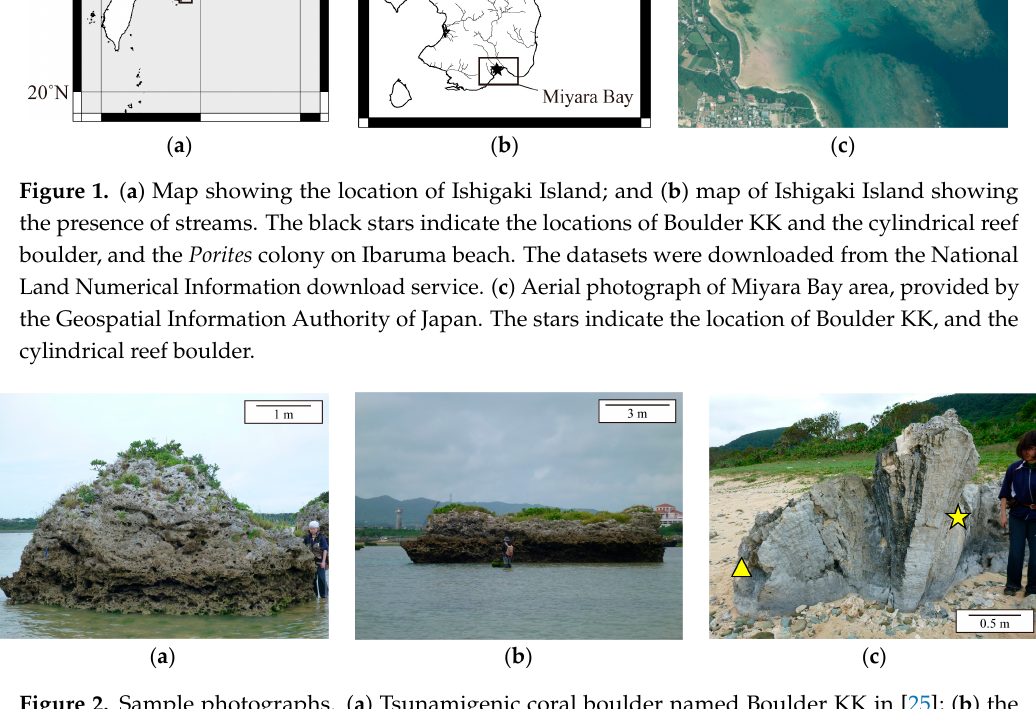
Figure 2. Sample photographs. ( a ) Tsunamigenic coral boulder named Boulder KK in [25]; ( b ) the roughly cylindrical reef boulder with a diameter of 10 m and a height of ~3 m (IST16); ( c ) a Porites colony thrown up on Ibaruma beach. The triangle and star indicate the sampling points of K09 and IB02, respectively.